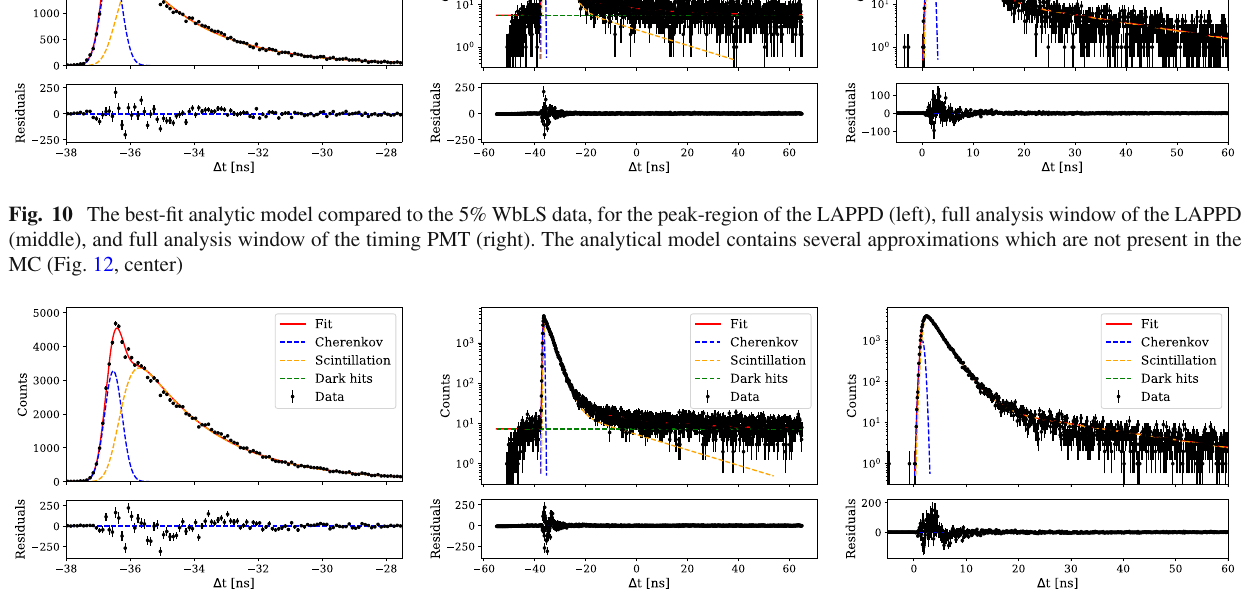
Fig. 11 The best-fit analytic model compared to the 10% WbLS data, for the peak-region of the LAPPD (left), full analysis window of the LAPPD (middle), and full analysis window of the timing PMT (right). The analytical model contains several approximations which are not present in the MC (Fig. 12,